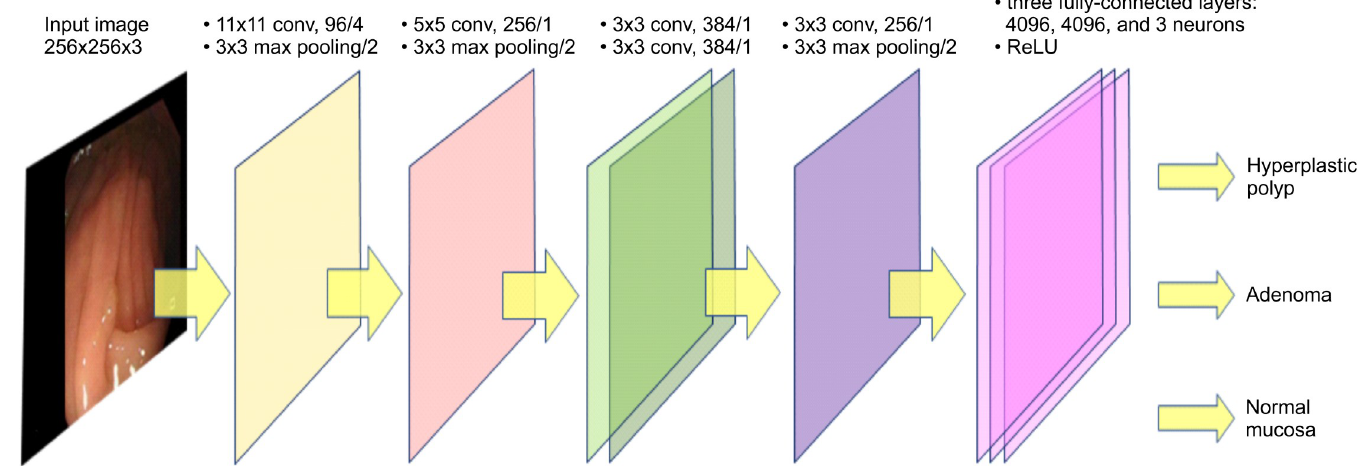
Fig 1. Architecture of AlexNet system (second-generation model).